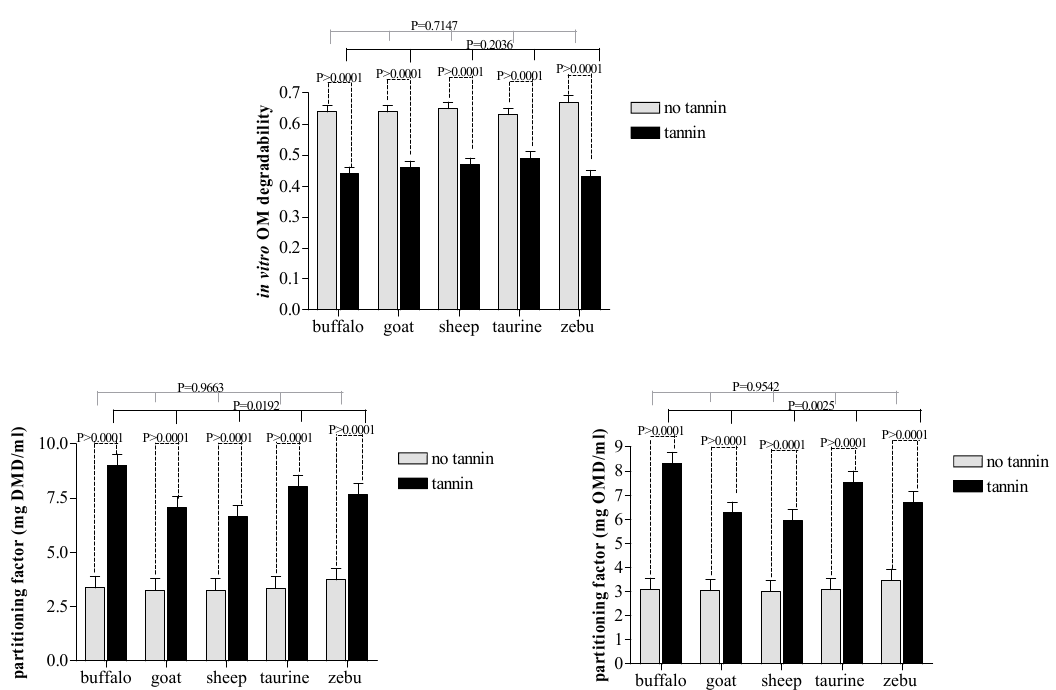
Figure 3. E ff ects of condensed tannin and animal species interactions on the organic matter degradability and partitioning factor during in vitro rumen fermentation.